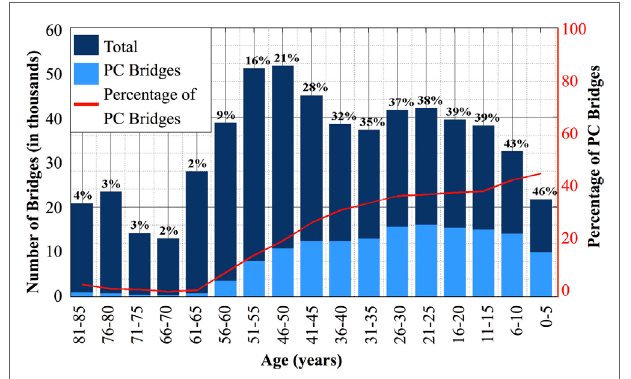
FIGURe 1 | Proportion of prestressed concrete bridges by age [data from Federal highway Administration (2014) .